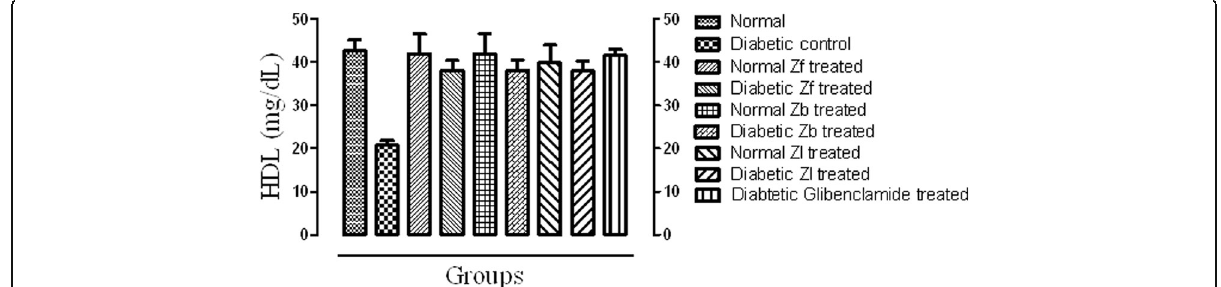
Fig. 4 Effect of extracts and standard drug on serum high density lipoproteins (mg/dL) level of normal and alloxan monohydrate induced diabetic